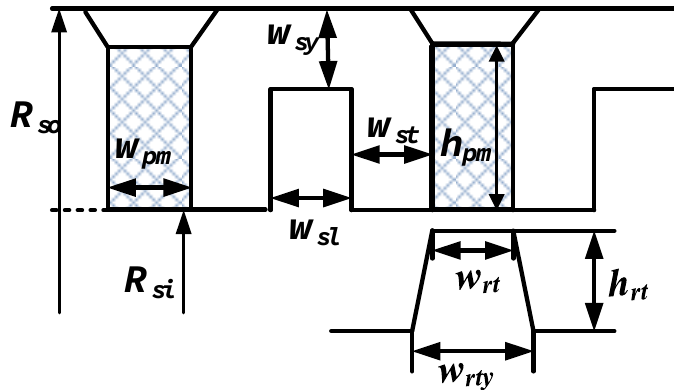
Figure 2. Key design geometric parameters of the FSPM generator. Table 2. Initial design parameters of the FSPM generator. Parameters